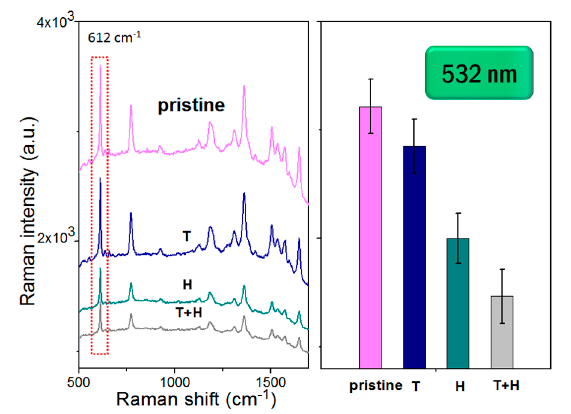
Figure 2. Results of physical treeatments on the SERS effectivity of silver grating (R6G moldecules are used as